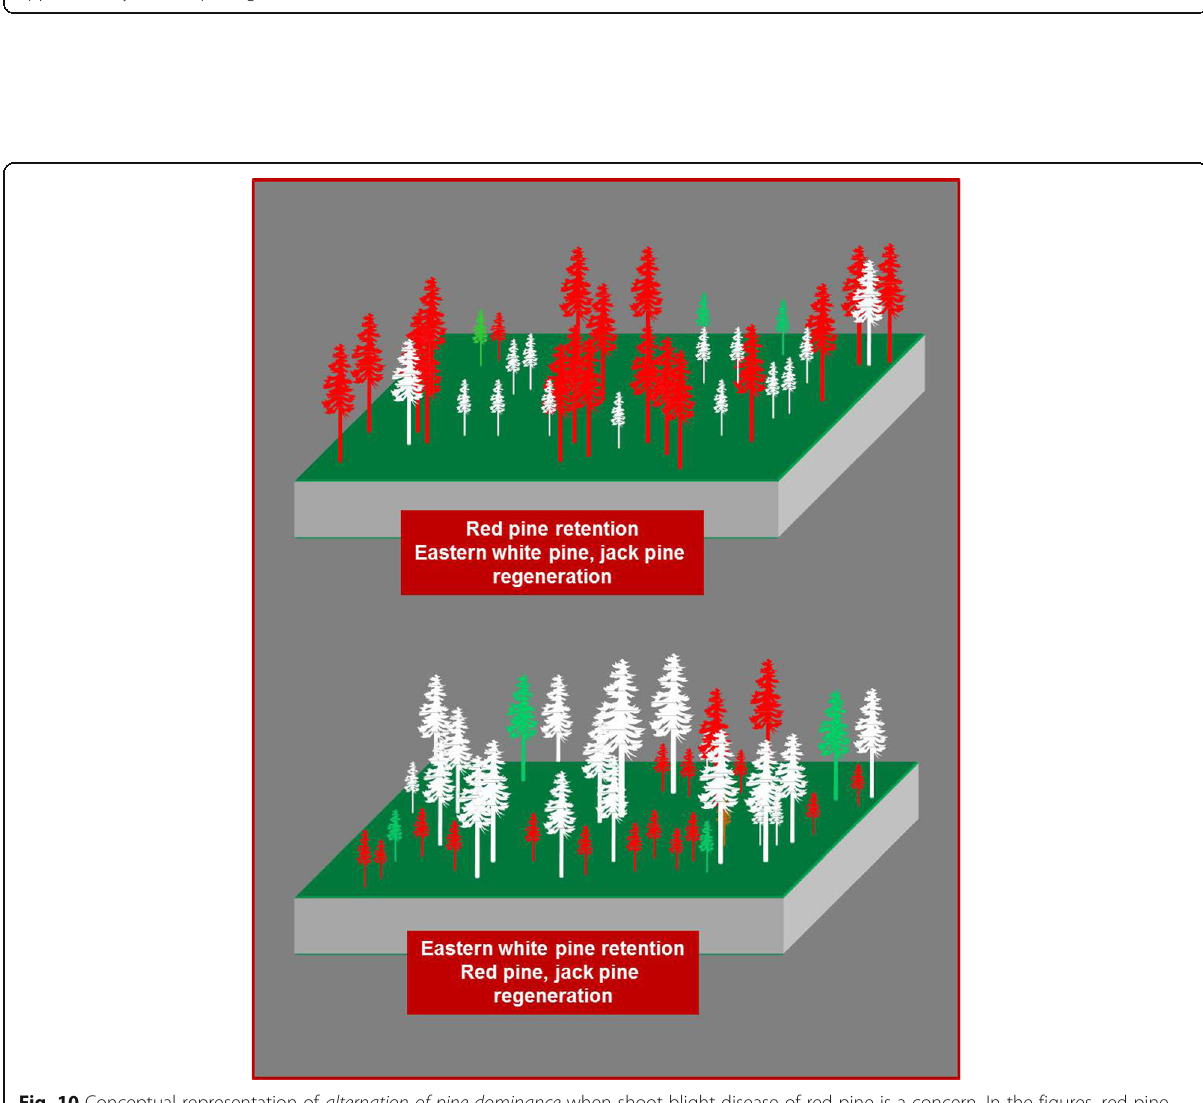
Fig. 10 Conceptual representation of alternation of pine dominance when shoot blight disease of red pine is a concern. In the figures, red pine are colored red, eastern white pine are colored white, and jack pine are colored green. Dominant composition of retention trees shifts between red pine (top) and eastern white pine (bottom) with regeneration focused on the opposite species and any additional native species. This alternation breaks up the spatial association of overstory red pine with resident shoot blight with highly susceptible red pine